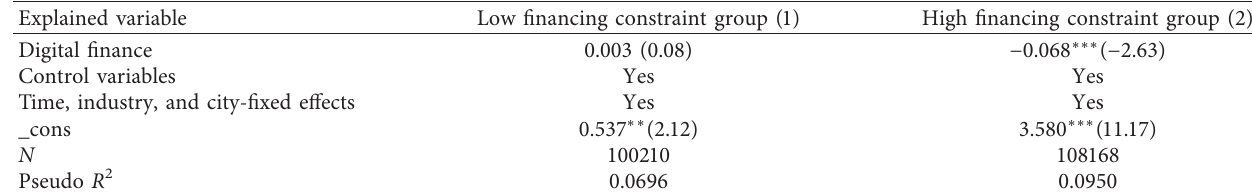
Table 4: Regression results on mechanism